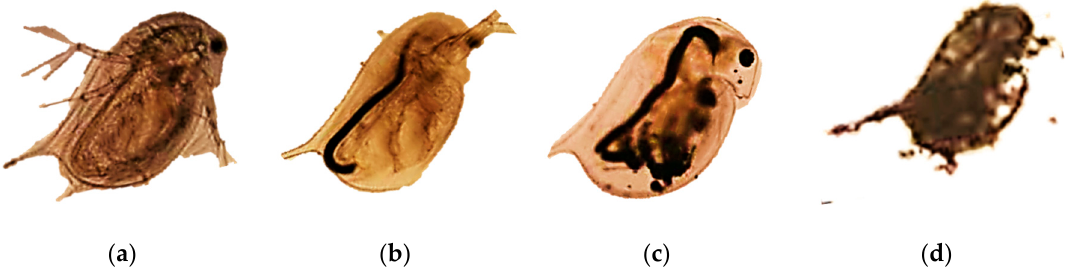
Figure 26. The uptake and adsorption of multi-wall carbon nanotubes (MWCNTs) by Daphnia magna after 48 h of exposure. ( a ) control; ( b ) 5 mg / L MWCNTs; ( c ) 50 mg / L MWCNTs and ( d ) 100 mg / L MWCNTs. (Modified after [75] ).